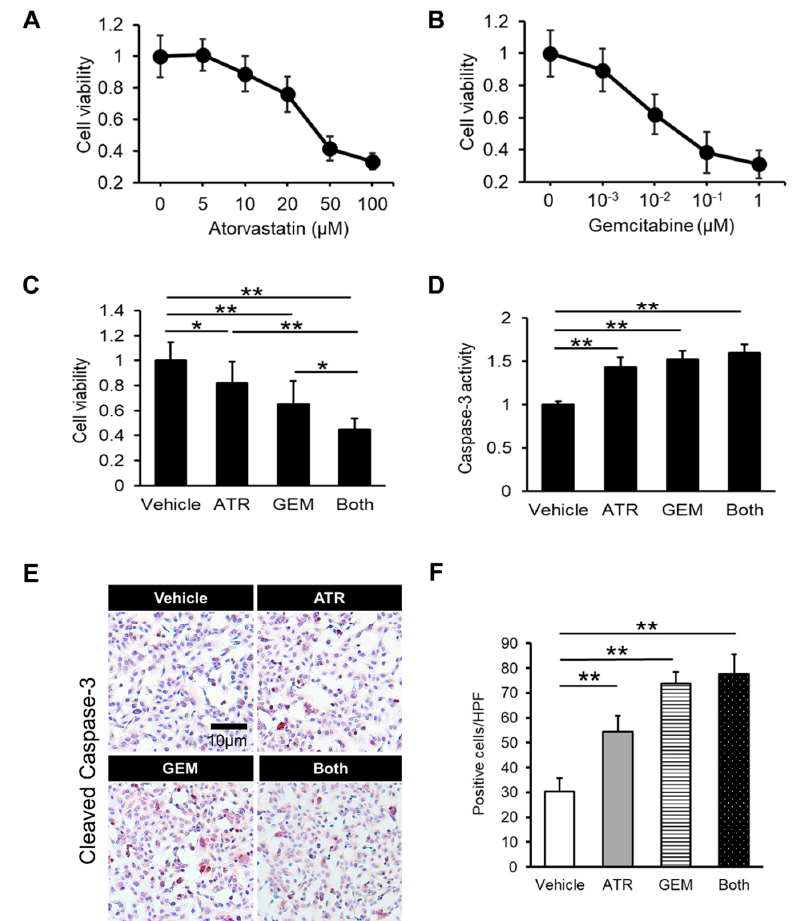
Figure 1. Effects of atorvastatin and gemcitabine on in vitro HuCCT-1 cell growth. ( A , B ) Concentration-dependent effects of atorvastatin (0–100 μ M) ( A ) and gemcitabine (0–1 μ M) ( B ) on the growth of HuCCT-1 cells. ( C ) Combined effect of atorvastatin (20 μ M) and gemcitabine (1 × 10 − 2 μ M) on HuCCT-1 cell growth. ( D ) Combined effect of atorvastatin (20 μ M) and gemcitabine (1 × 10 − 2 μ M) on caspase-3 activity in HuCCT-1 cells. ( E ) Immunocytochemistry of cleaved caspase 3 (CC3). ( F ) Quantification of CC3-immunopositive cells. ATR, treatment with 20 μ M atorvastatin. GEM, treatment with 1 × 10 − 2 μ M gemcitabine. Both, combined treatment with 20 μ M atorvastatin and 1 × 10 − 2 μ M gemcitabine. Data are presented as the mean ± SD ( n = 10). * p < 0.05; ** p < 0.01.